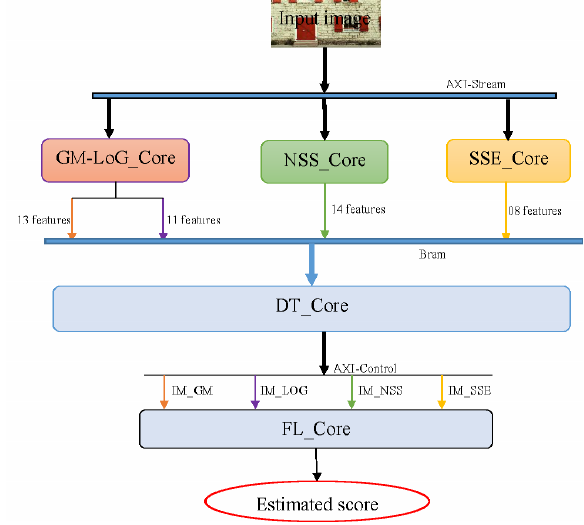
Figure 7. Implementation architecture of the ILBQA on an FPGA platform. Table 11. Device performance utilization estimates in HLS synthesis